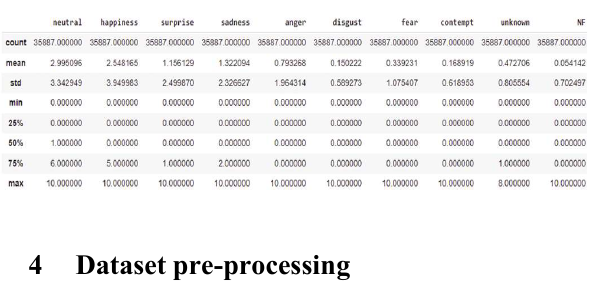
Table 2 . Statistical information on dataset